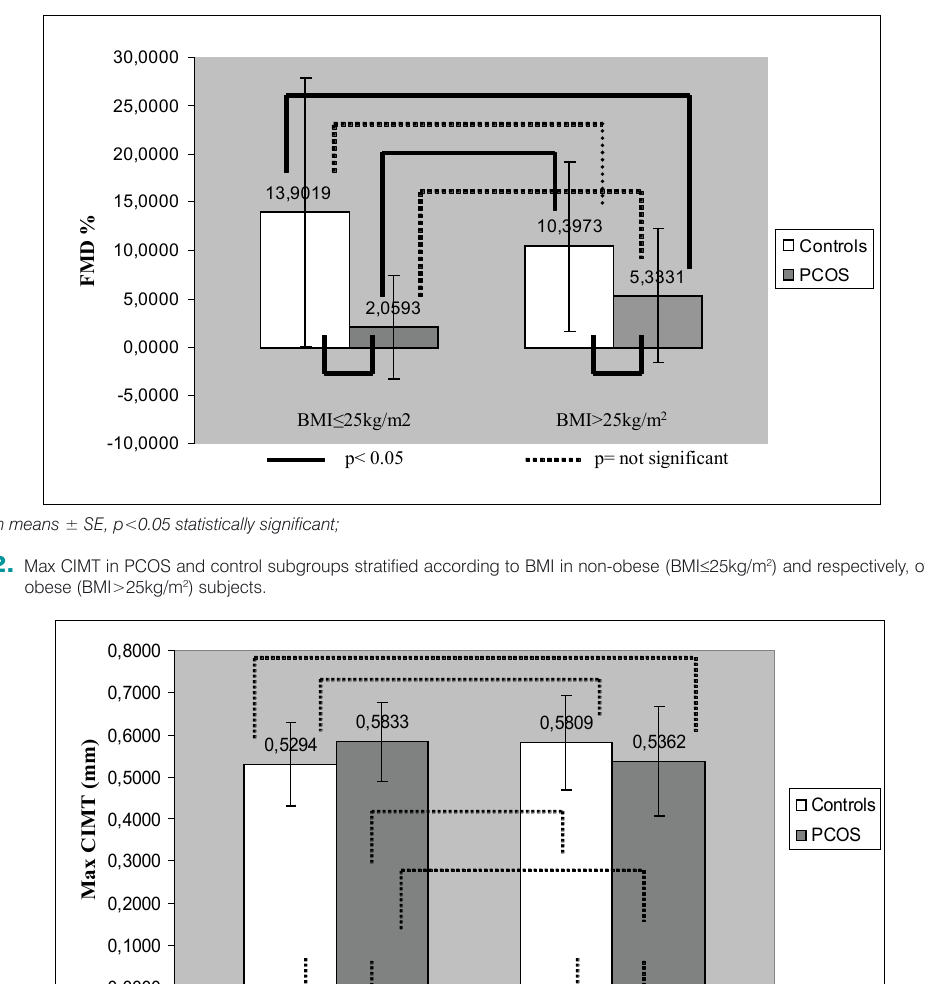
Figure 1. FMD % in PCOS and control subgroups stratified according to BMI in non-obese (BMI ≤ 25kg/m 2 ) and respectively, overweight and obese (BMI>25kg/m 2 ) subjects.